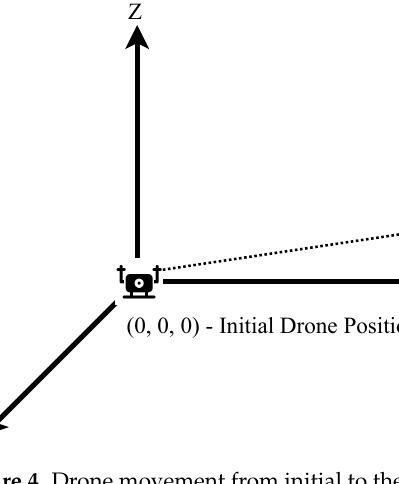
Figure 4. Drone movement from initial to the desired